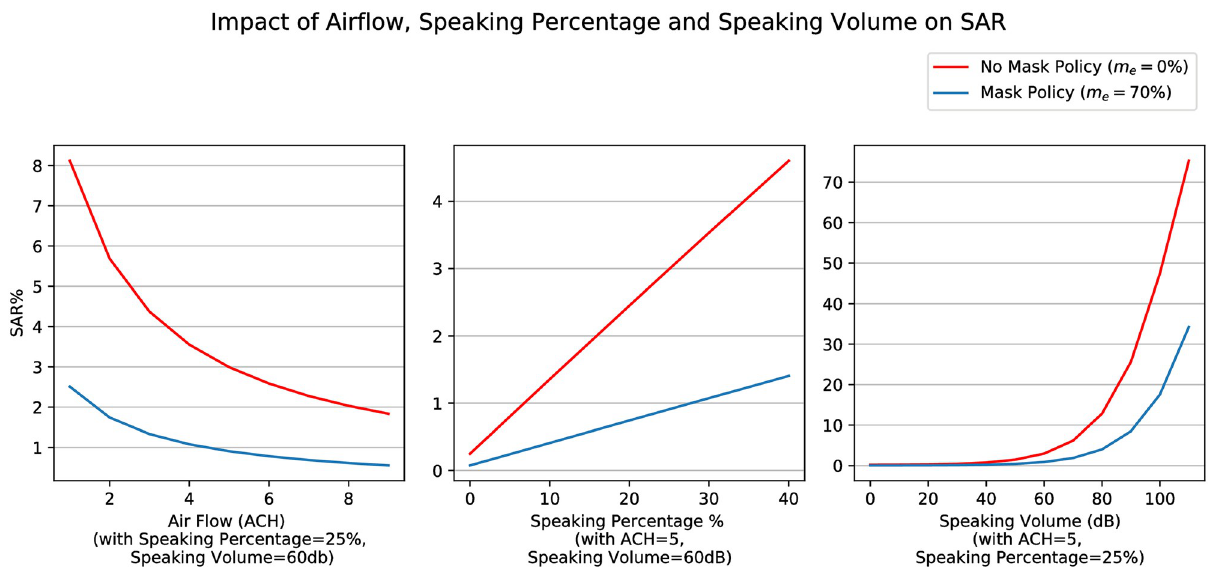
Fig 1. SAR variation. Impact of airflow, speaking volume, speaking percentage, and mask effectiveness on